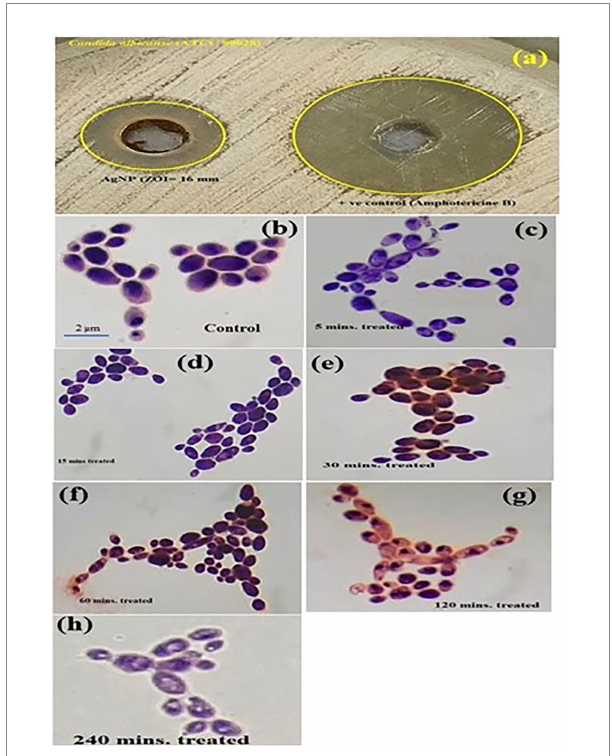
(C) treated for 5 min; (D) 15 min; (E) 30 min; (F) 60 min; (G) 120 min; and (H) 240 min.